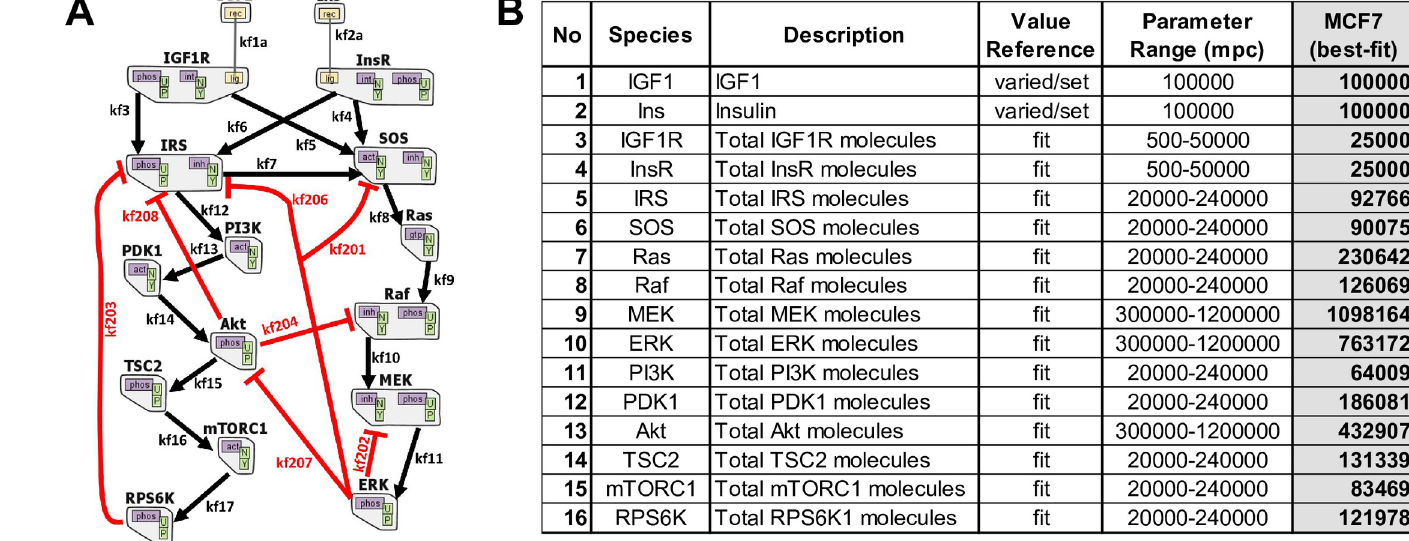
PLOS Computational Biology | https://doi.org/10.1371/journal.pcbi.1009125 June 30,